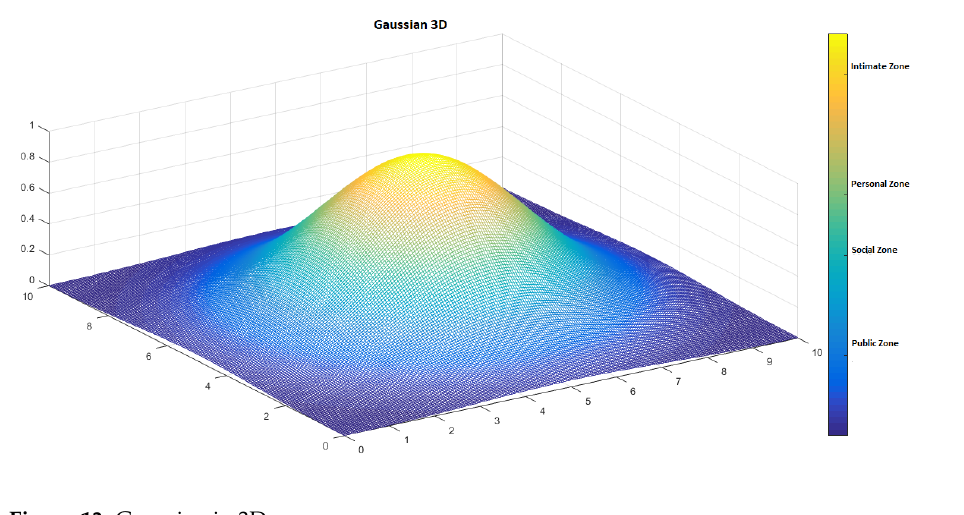
Figure 13. Gaussian in 3D.